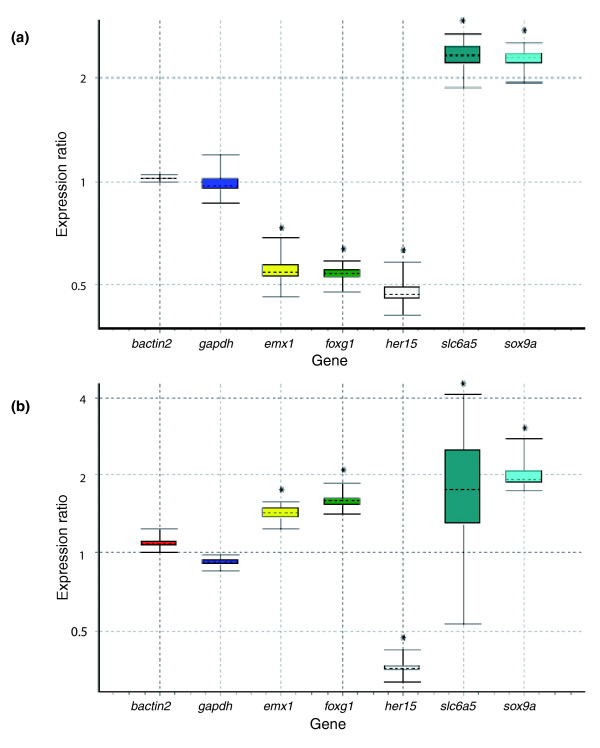
Validation using quantitative PCR. Individual genes with different biological roles were selected from the reward pool (Figure 3a) for qPCR using original RNA from (a) wt+/wt- and (b) mut+/sib+. The qPCR experiment revealed selected genes showed expression changes similar to those seen in the microarray results. The figures show box plots of relative gene expression, where the top and the bottom of each box indicate the 75th and 25th percentiles, respectively, whereas the dotted line represents the median. Asterisks indicate that the probability of the alternative hypothesis (that the difference between sample and control groups is only due to chance (P(H1)) being correct is ≤ 0.05 (see also Materials and methods).